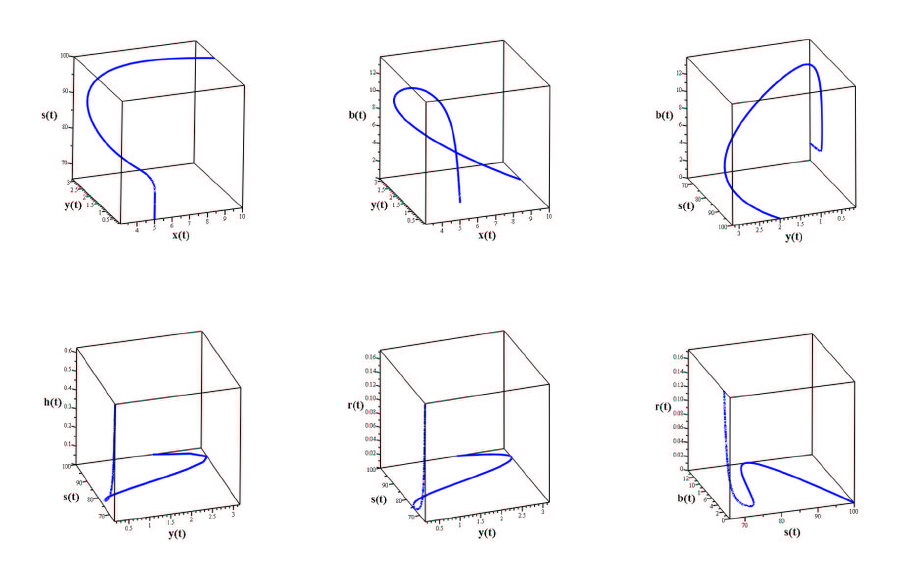
Figure 8: Phase portraits using 5-term MsDTM with r 0 = 1.06 and R 0 ≈ 3.5 .